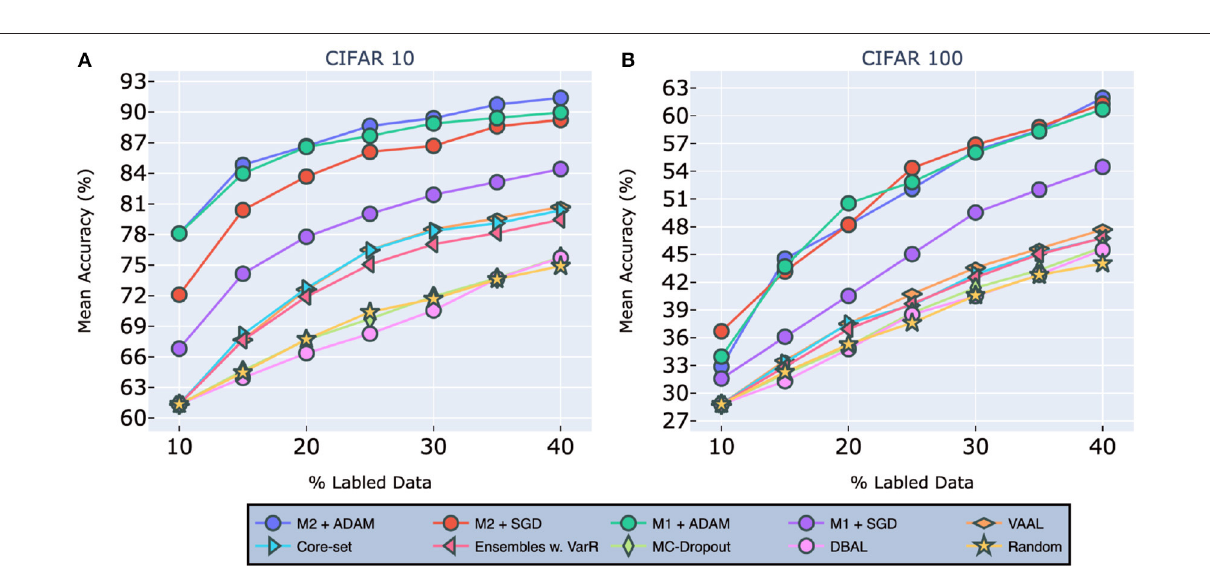
FIGURE 4 | Performance on classification tasks for CIFAR-10 (A) and CIFAR-100 (B) compared to VAAL (Sinha et al., 2019), Core-set (Sener and Savarese, 2017), Ensembles w. VarR (Beluch et al., 2018), MC-Dropout (Gal and Ghahramani, 2016), DBAL (Gal et al., 2017), and Random Sampling. M1 indicates our model (2) and M2 indicates our model (1). All the legend names are in descending order of final accuracies. Best visible in color. Prior results adapted from Sinha et al.